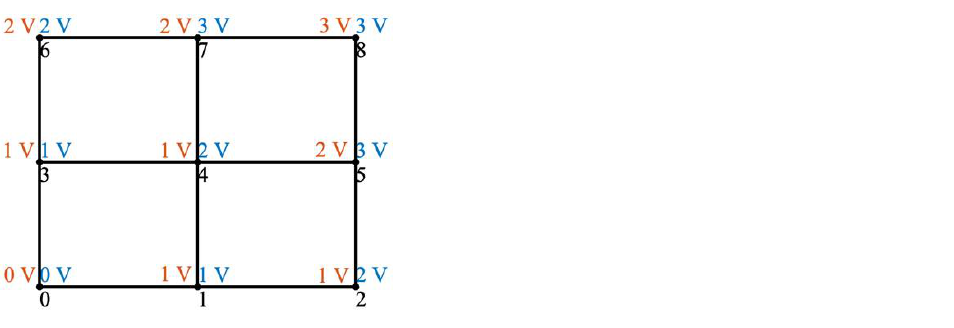
Figure 12. Node voltage solutions for 3 × 3 lattice converter shown in Figure 7. Orange: first solution; blue: second solution.